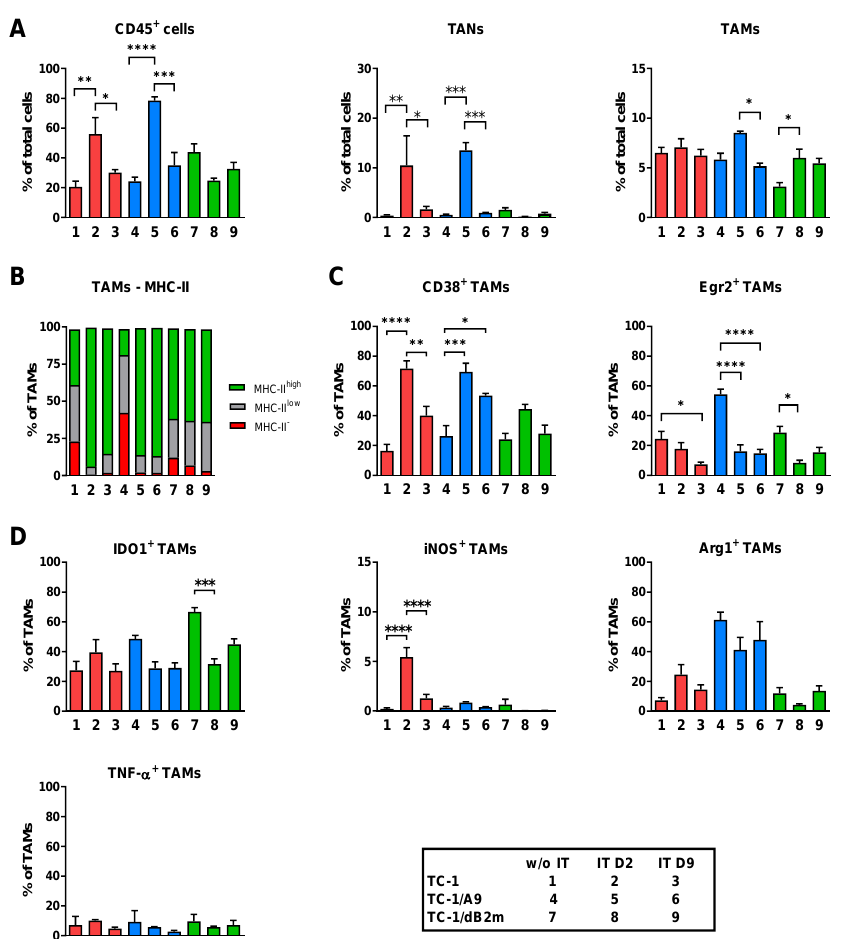
Figure 2. Ex vivo characterization of TAMs. Mice ( n = 4) were injected with tumor cells and subsequently treated with combined IT, consisting of immunization by a gene gun and i.p. injection of the ODN1826 adjuvant, as described in Material and Methods. On days 2 (D2) and 9 (D9) after completion of treatment, cells were isolated from tumors, and myeloid cells were analyzed by flow cytometry. Non-treated tumors were used as a control. ( A ) Infiltration of tumors with immune cells (CD45 + ), TANs (CD11b + Ly6G high Ly6C low ), and TAMs (CD11b + Ly6G − Ly6C − F4/80 + ). ( B ) Overview of the mean percentages of TAM subpopulations as determined by MHC-II expression. ( C ) Analysis of M1 and M2 TAM frequencies using CD38 and Erg2 markers, respectively. ( D ) Frequencies of TAMs expressing the amino acid-degrading enzymes iNOS, arginase 1, and IDO1, and the cytokine TNF-α. Bars: ± SEM; * p < 0.05, ** p < 0.01, *** p < 0.001, **** p < 0.0001.